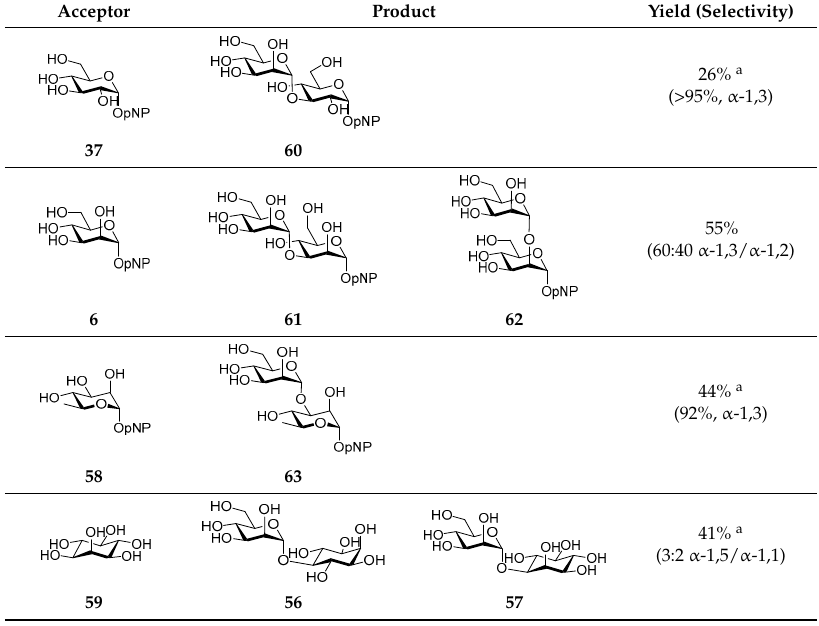
Table 2. Synthetic products of α -mannosylation catalyzed by the MalA D320G [55]. All reactions were carried out with β ManF as the donor. Different regioselectivities were observed depending on the acceptor structure and anomeric configuration. Yields were determined after purification or isolation.